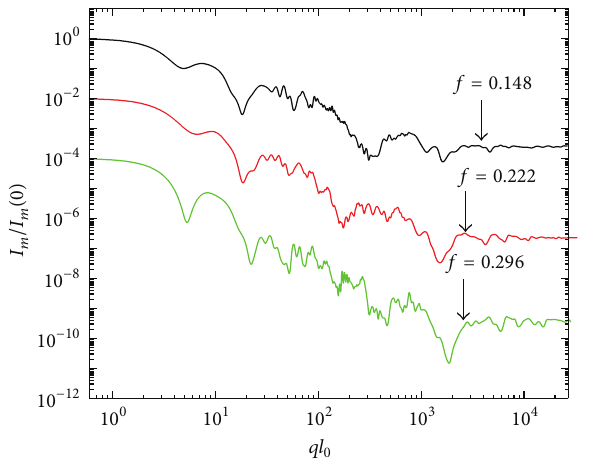
Figure 4: The polydisperse structure factor for the fragmentation model at various values of probability 𝑓 shows a simple power-law decay in the fractal region with the scattering exponent equal to the fractal dimension of the fractal. The horizontal lines indicate the asymptotic values of the structure factor (see (12)). Iteration number is 𝑚 = 6 and relative variance 𝜎 𝑟 = 0 .